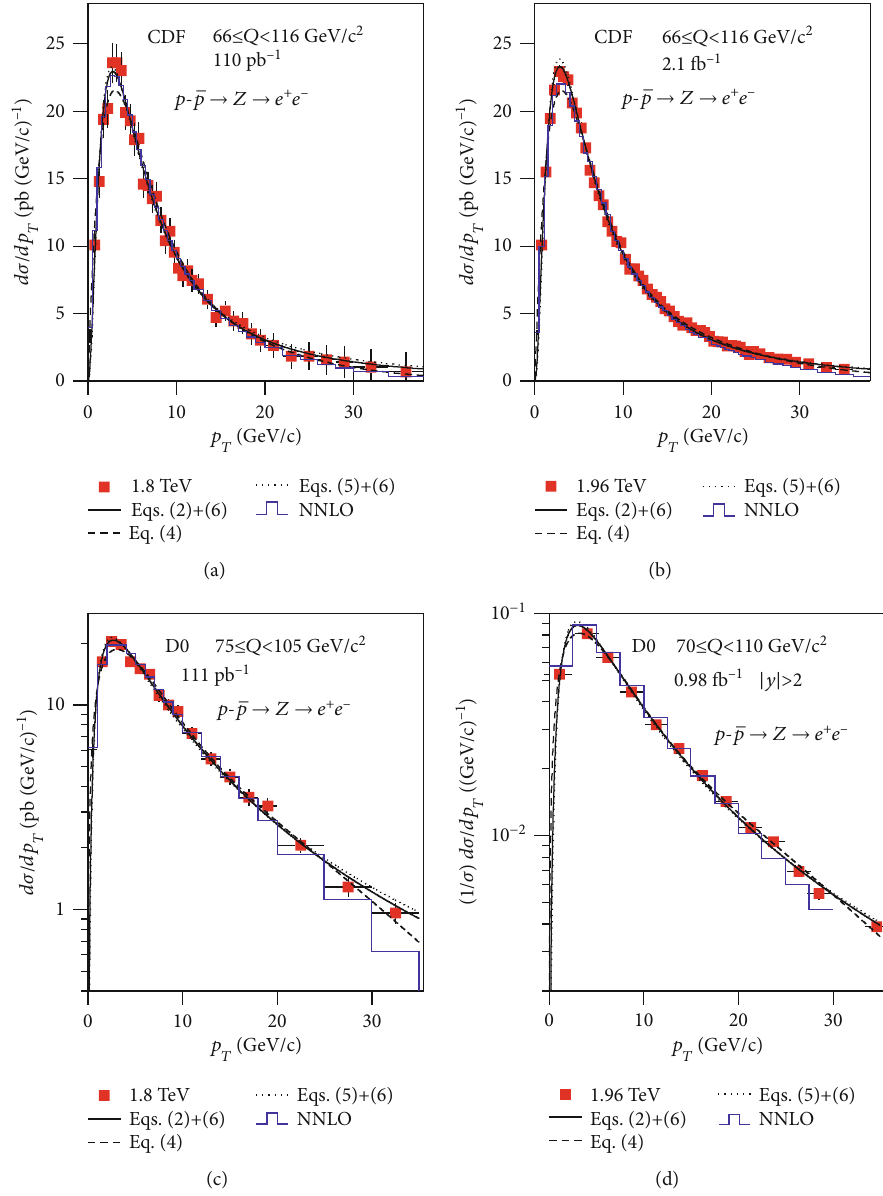
ℓ (cid:1) ℓ (with di ff erent invariant masses Q ) produced by the Drell-Yan process in p (cid:1) p Figure 3: Same as Figure 2, but showing the p ffiffi p T spectra of s = 1 : 8 (a, c) and 1.96 TeV (b, d). The data points are quoted from the CDF (a, b) [48, 49] and D0 Collaborations (c, d) collisions at (cid:1) ℓ [50 – 52]. In all panels, ℓ is e + e − , see text in subsection 3.3 for the meanings of histograms which are quoted from QCD